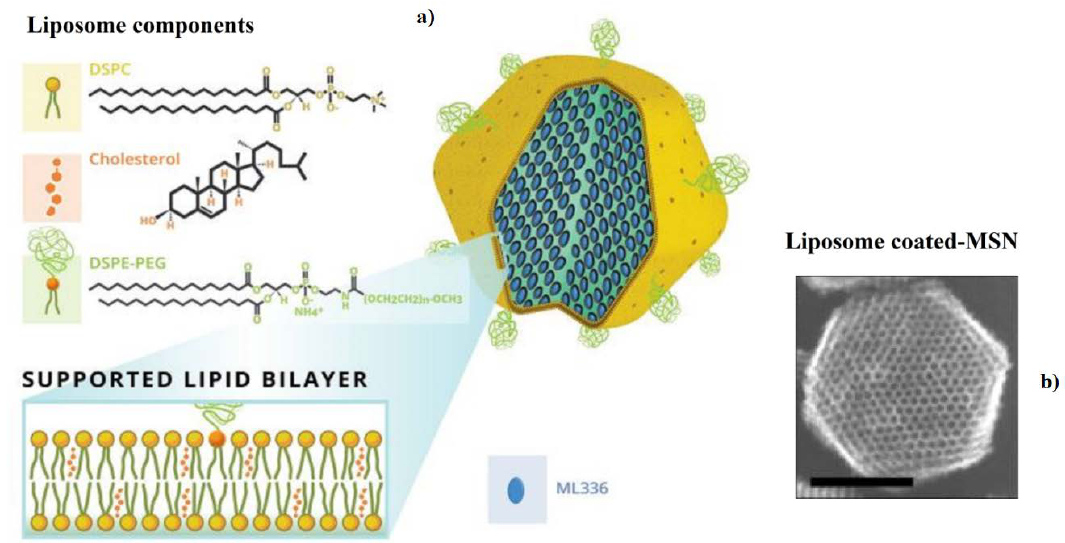
Figure 5. ( a ) Schematic and ( b ) TEM images of liposome-coated mesoporous silica